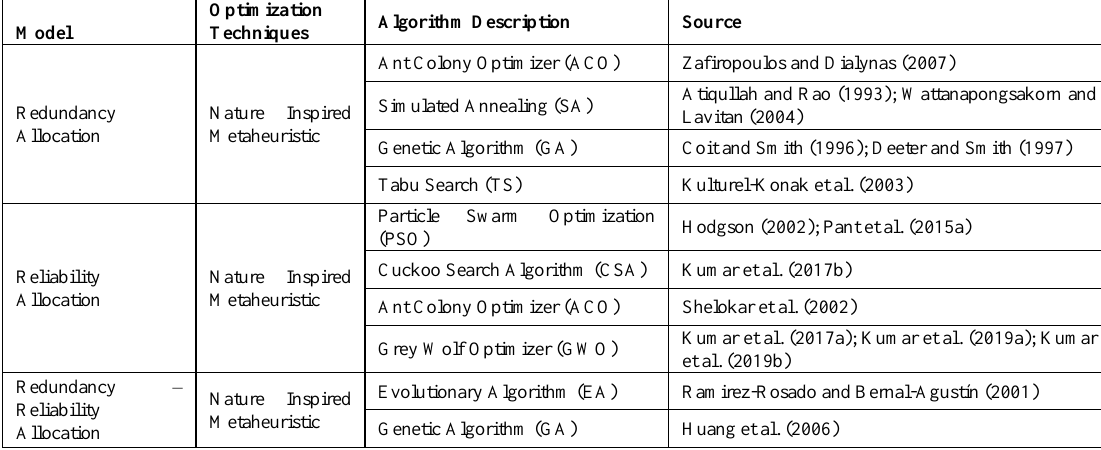
Table 1. Applications of metaheuristics to reliability